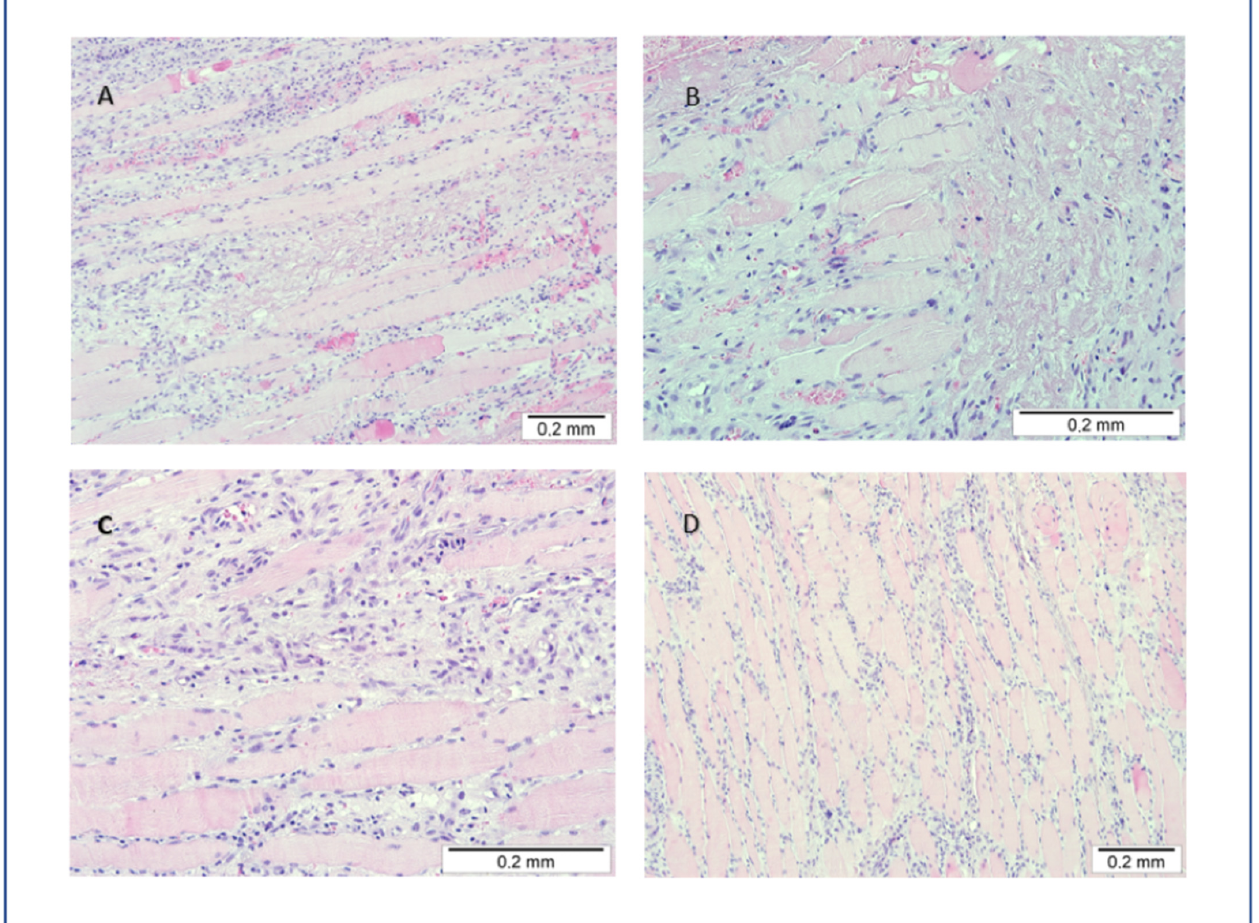
Figure 3. Histopathological presentation. ( A ) Areas of muscle necrosis and edema with extravasation of blood (HE, ×100). ( B ) Necrotic muscle fibers with focal replacement of necrotic fibers by loose fibrotic tissue (HE, ×200). ( C ) Early fibrotic tissue with mononuclear cell infiltration (HE, ×200). ( D ) Signs of muscle fiber regeneration with scanty lymphocytic infiltrates (HE, ×100).